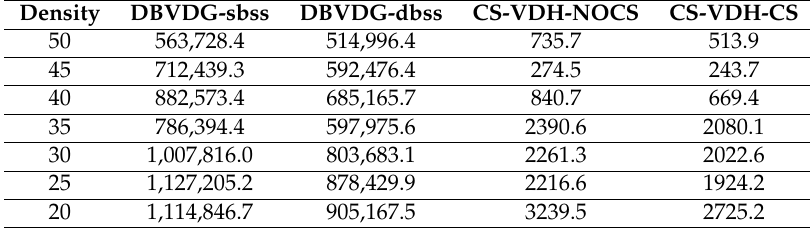
Table 7. Control overhead (total num. of generated messages) of both